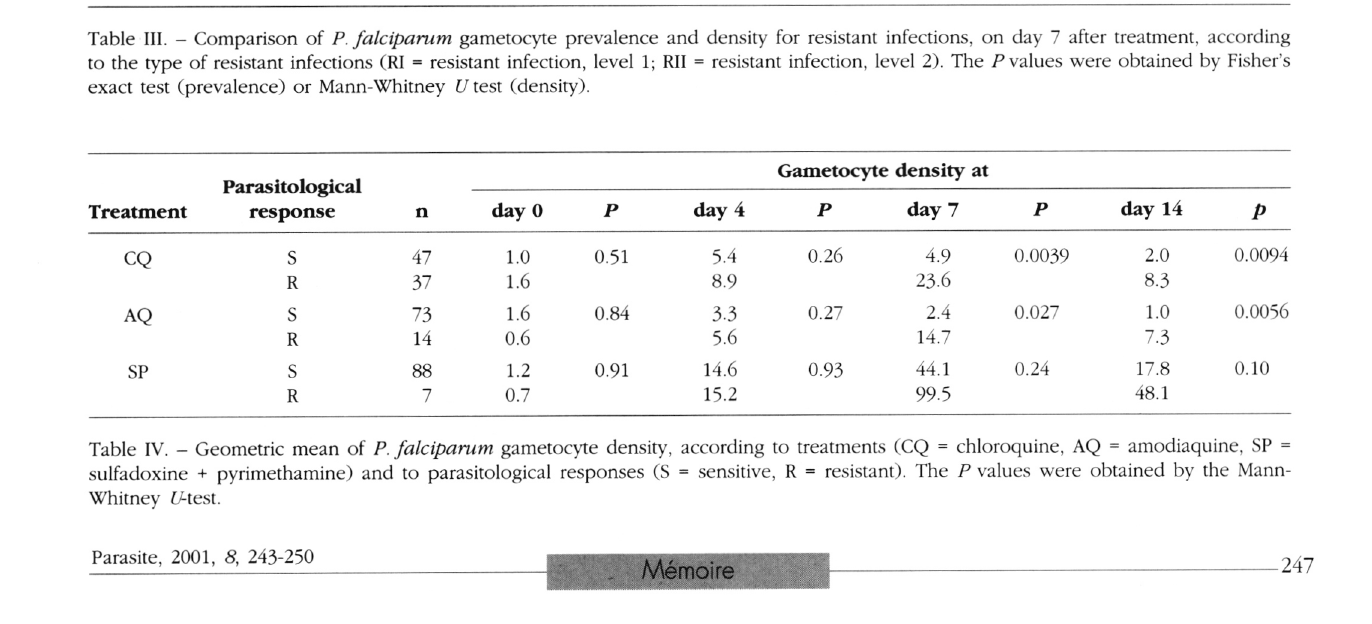
Table III. - Comparison of P. falciparum gametocyte prevalence and density for resistant infections, on day 7 after treatment, according to the type of resistant infections (RI = resistant infection, level 1; RII = resistant infection, level 2). The P values were obtained by Fisher’s exact test (prevalence) or Mann-Whitney U test (density).